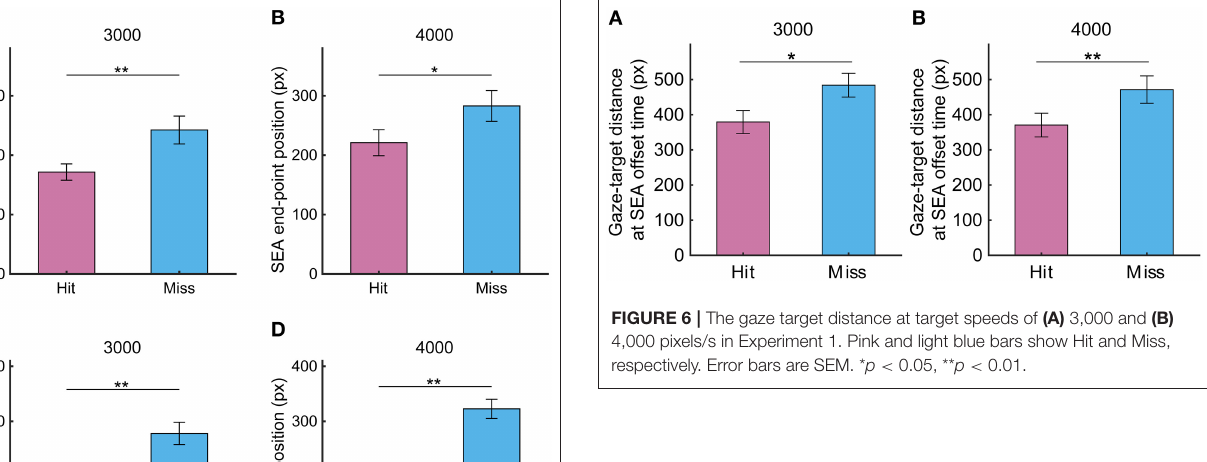
of SEA that the gaze reached the Hit zone, finding 57.8 ± 5.0